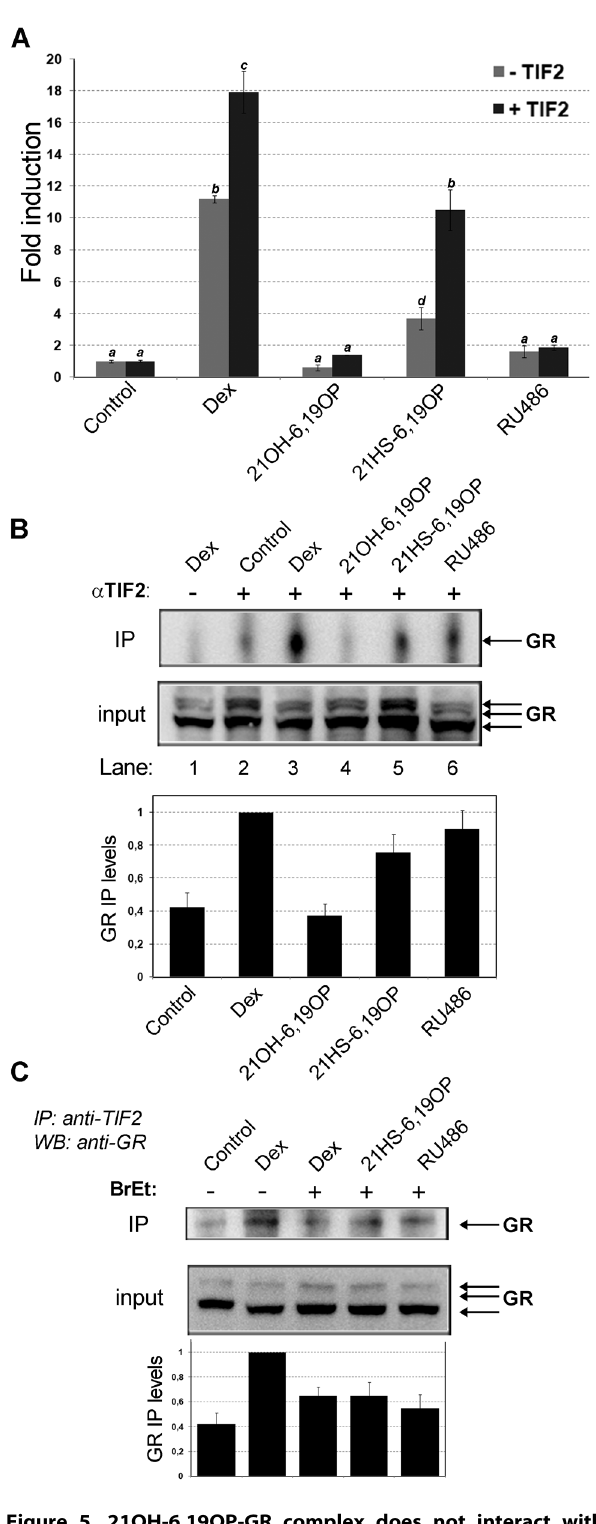
Figure 5. 21OH-6,19OP-GR complex does not interact with TIF2. A . BHK21 cells were cotransfected with MMTV-Luc vector in the presence ( + TIF2) or absence (-TIF2) of pTIF2 expression vector. pCMV- LacZ vector were also introduced. Cells were incubated for 18 h with ethanol (Control), 10 nM Dex, 10 m M 21OH-6,19OP, 10 m M 21HS- 6,19OP, and 1 m M RU486. Luciferase activity was determined and normalized against b -galactosidase activity. Values are expressed as fold induction relative to controls. Means 6 S.E. from three